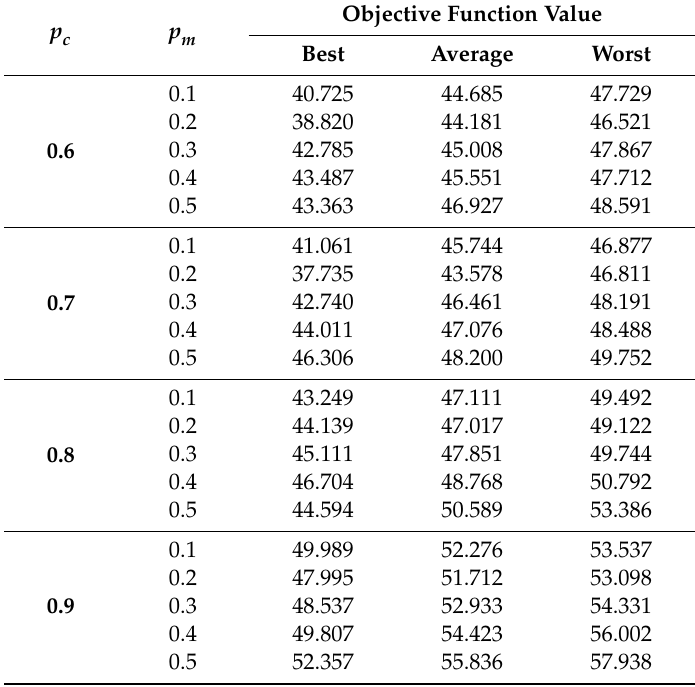
The objective function values obtained by O-ELGA for di ff erent crossover and mutation